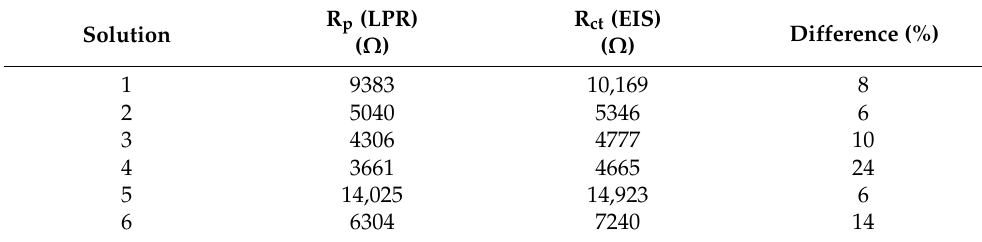
Table 4. R p obtained by LPR and